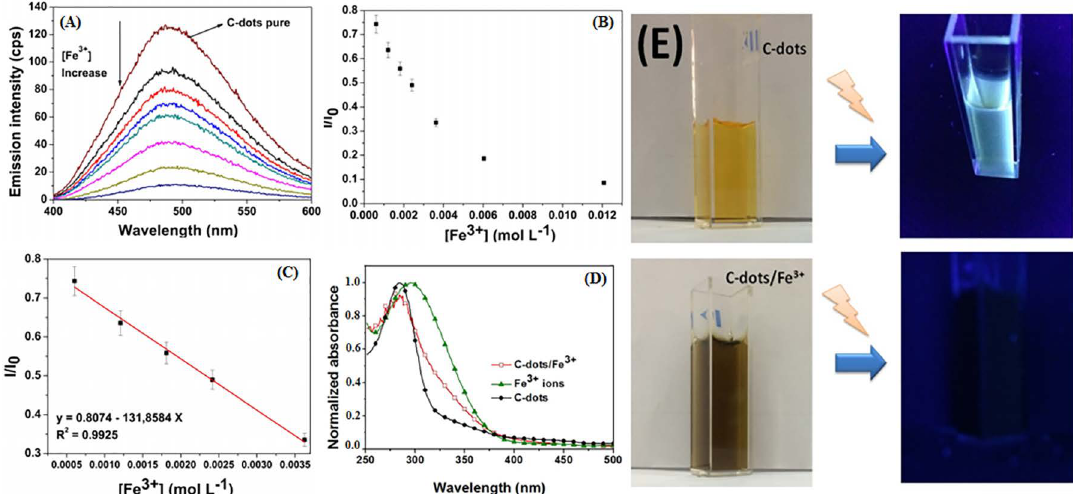
Figure 6. (A) Typical PL emission spectra of as-prepared C-dots in the presence of increasing Fe 3+ concentrations (0 - 40 mM). (B) The relationship between I/I and Fe 3+ concentrations. I and I are the PL intensities of C-dots excited at 360 nm in the presence and absence of 0 0 Fe 3+ ions, respectively.(C) The dependence of (I/I ) on concentrations of Fe 3+ .(D) UV-vis spectra of C-dots in the absence and the presence 0 of Fe 3+ ions. (E) Photographic image of C-dots in the presence and absence of Fe 3+ ions (under visible and UV